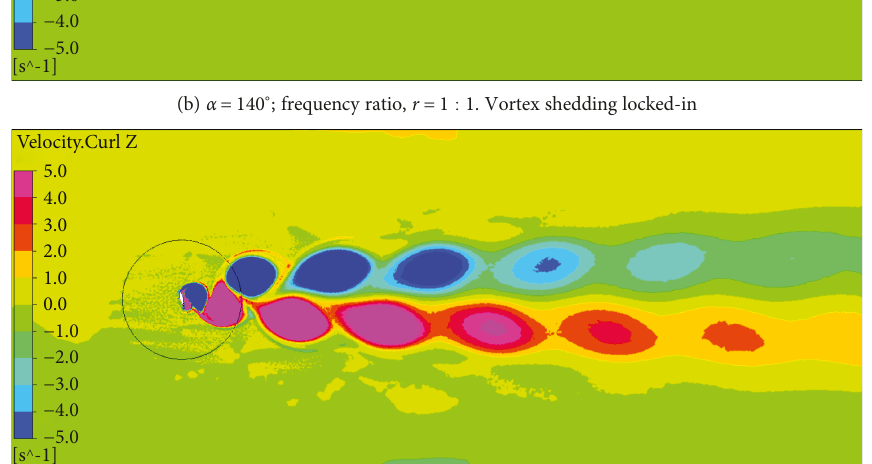
= 140 ° (a, b) and α = 70 ° (c), counter-clockwise mean mean